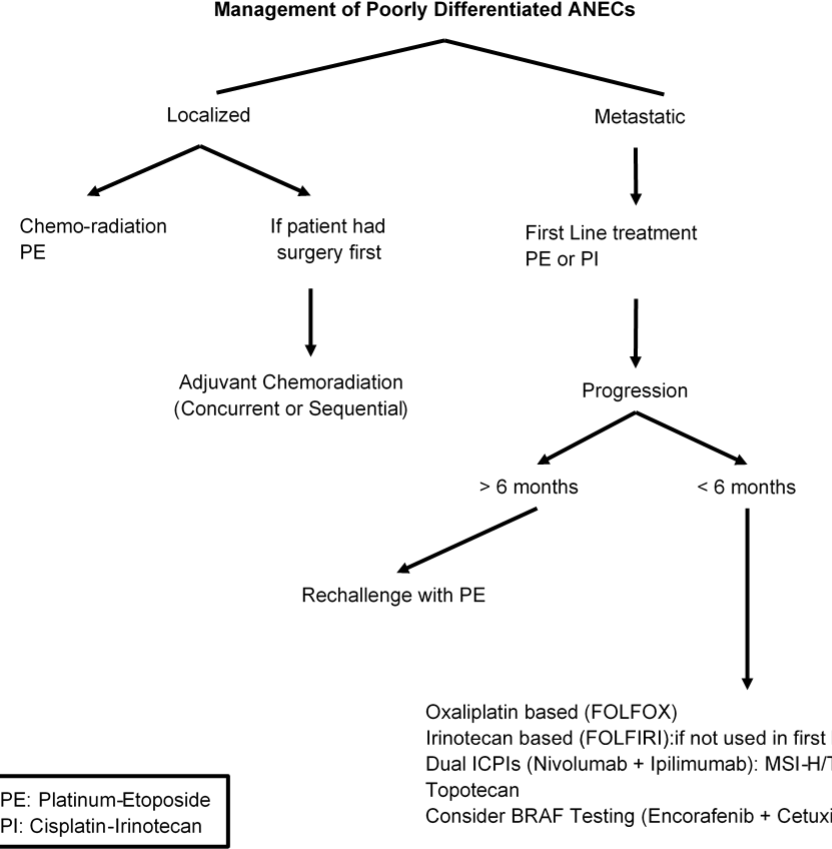
Figure 4. Management of Poorly Differentiated ANEC.